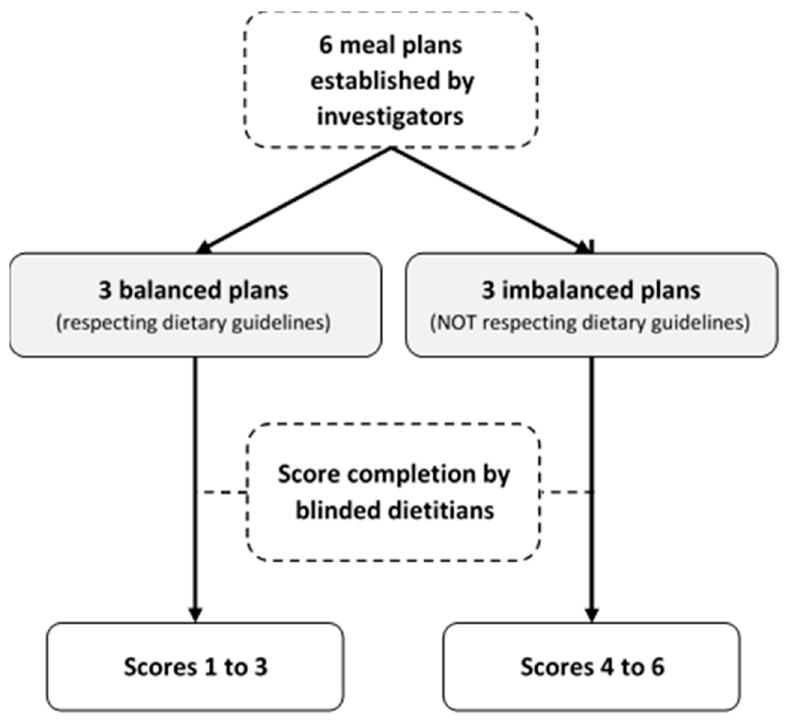
Figure A1. Construct validation process of SCASA (Score d’Alimentation Saine) .